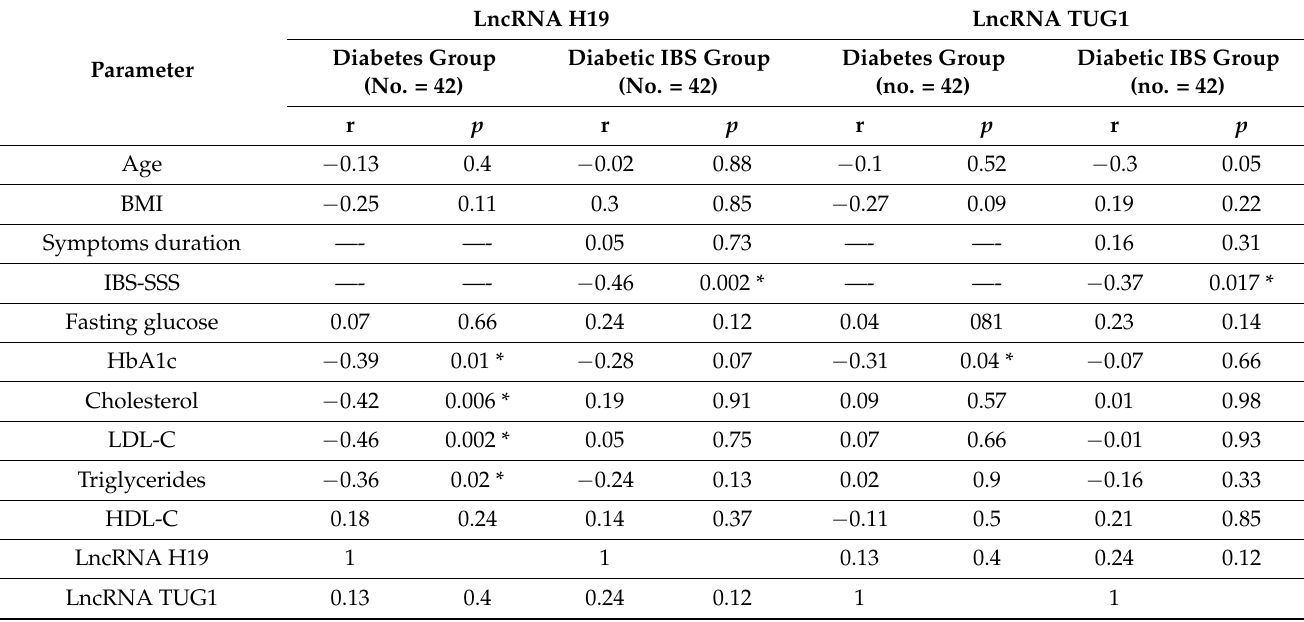
Table 3. Association of lncRNAs, clinical data, and laboratory data in the studied patients.